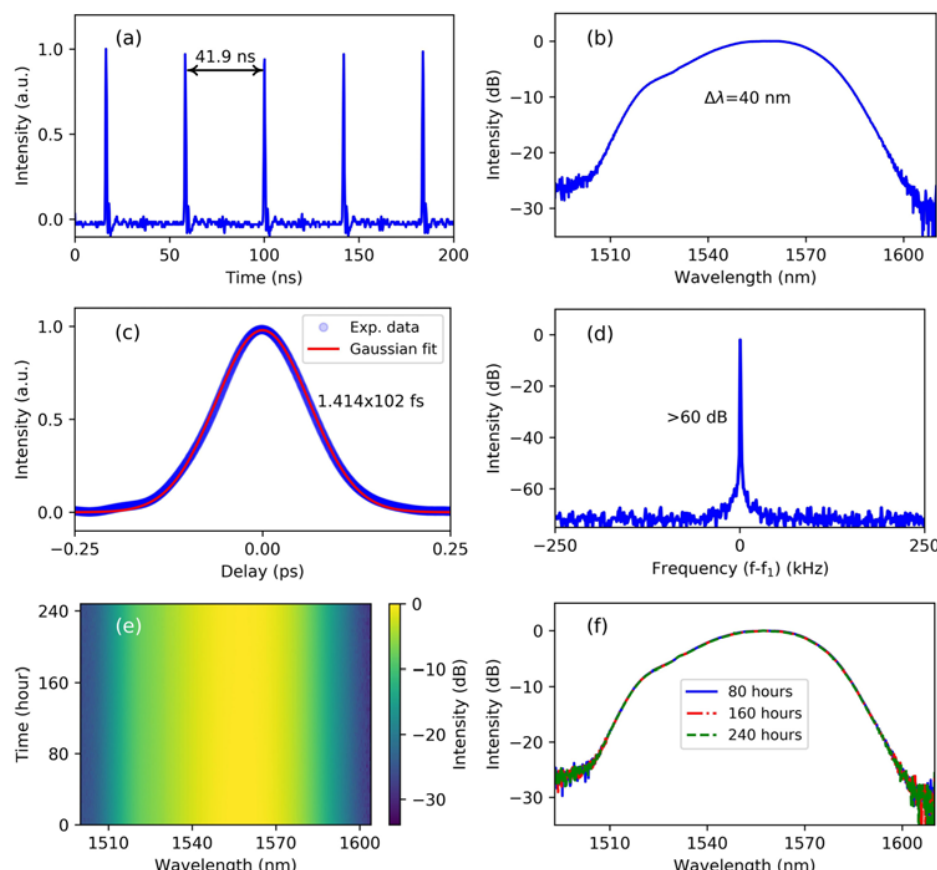
Figure 14. ( a ) Oscilloscope trace of the laser output. ( b ) Optical spectrum. ( c ) Autocorrelation trace with a Gaussian fit. ( d ) Radio frequency spectrum. ( e ) Spectra of long-term stable operation over 240 h. ( f ) Spectra acquired after 80 h (blue curve), 160 h (red dot line), and 240 h (green dot line), respectively. Reproduced from ref. [152]. Optical Society of America,